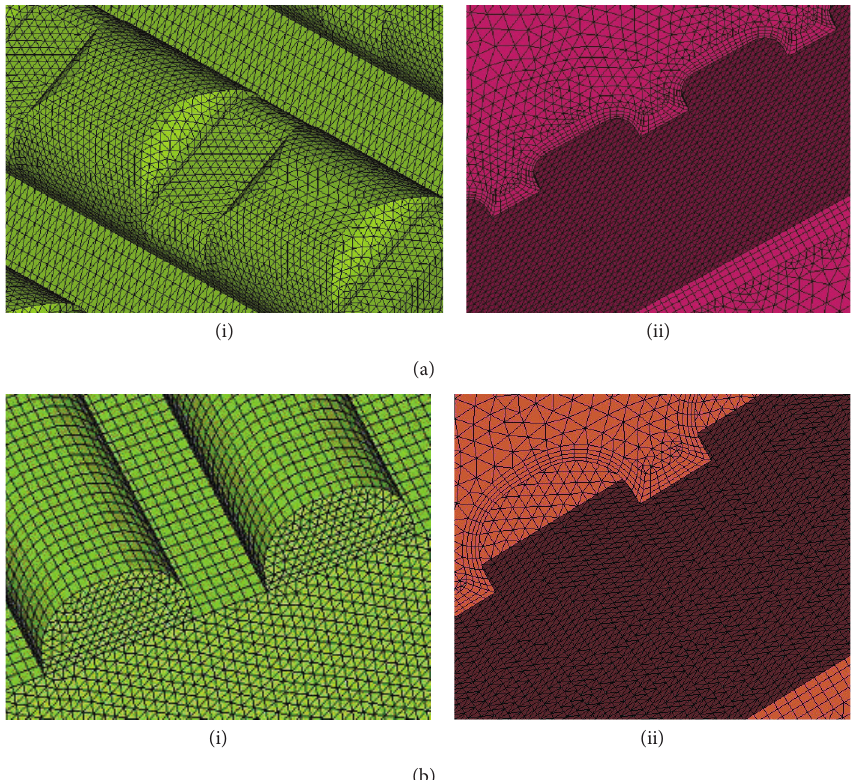
Figure 5: Local and interface meshes for solid and fluid domains: (a) CSM mesh, (i) local mesh of solid domain and (ii) interface mesh of fluid domain; (b) RMM mesh, (i) local mesh of solid domain and (ii) interface mesh of fluid domain.